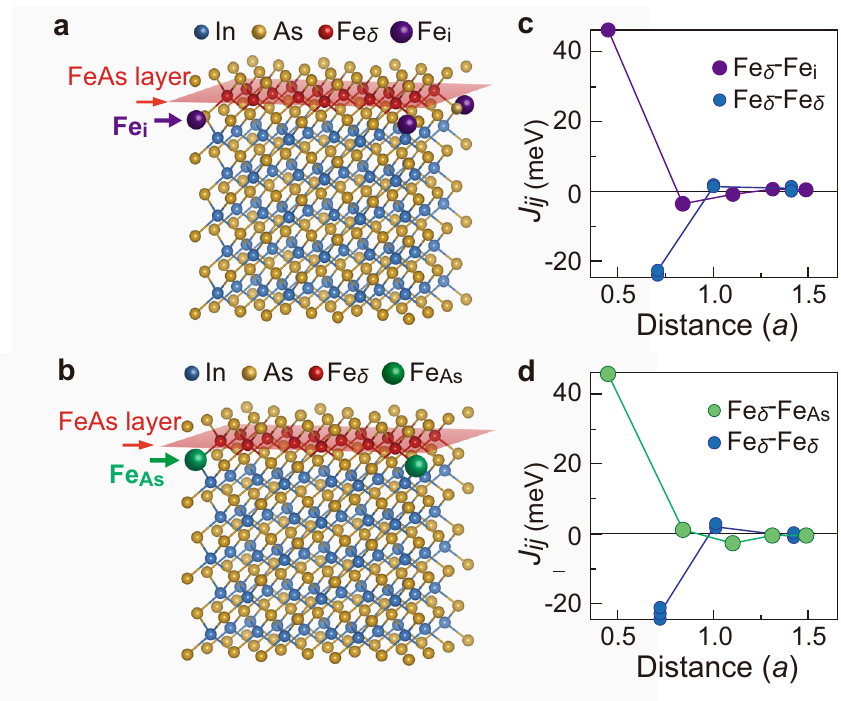
Fig. 5 First principles calculations with the KKRnano code of Fe – Fe magnetic interactions in FeAs/InAs SLs with Fe disorders. a , b FeAs/InAs SL structure ( t InAs = 5 MLs) with disordered positions of Fe atoms at the octahedral interstitial site (Fe i ) and As site (Fe As ), respectively. c , d Magnetic exchange interaction energy J ij between the Fe spins as a function of distance. Here the distance is expressed with a unit of a ( = 0.307 nm), which is half of the lattice constant of InAs (in our calculations, we assume that the InAs layers have the same lattice constant as that of the AlSb buffer due to epitaxial strain effect). Positive (negative) values of J ij represent ferromagnetic (antiferromagnetic) coupling between a pair of Fe spins.